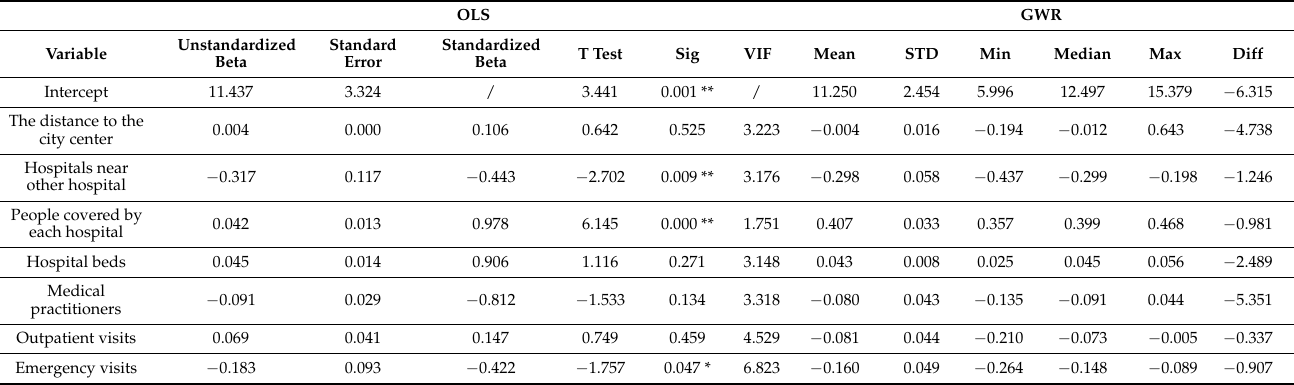
Table 2. OLS model and GWR parameter results.